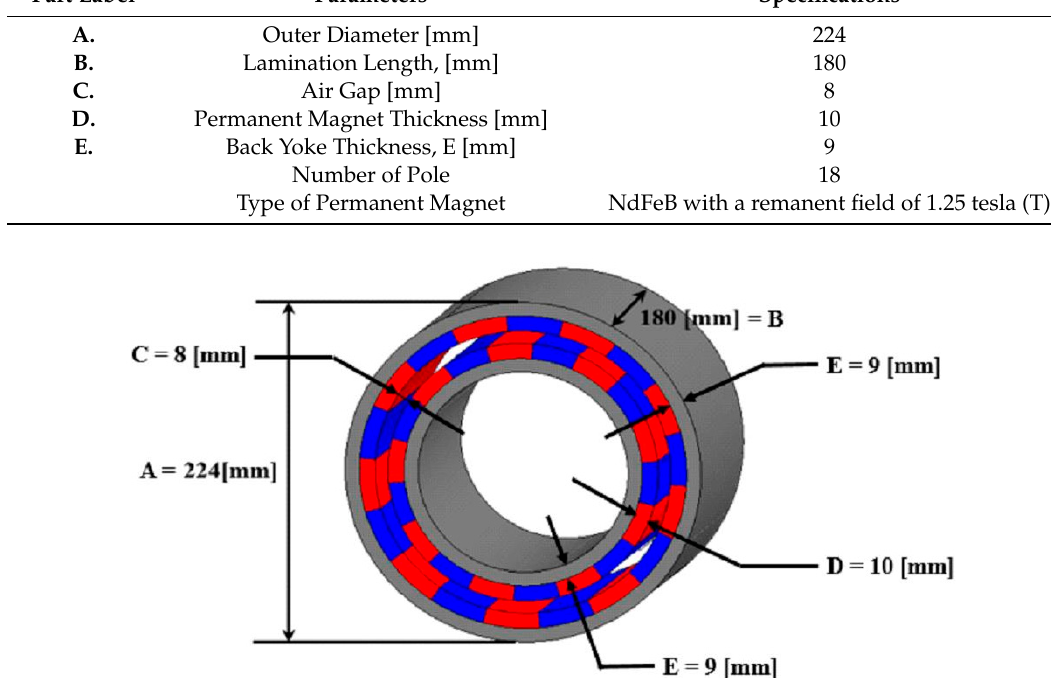
Table 6. Final design parameters of 10 kW magnetic coupling.